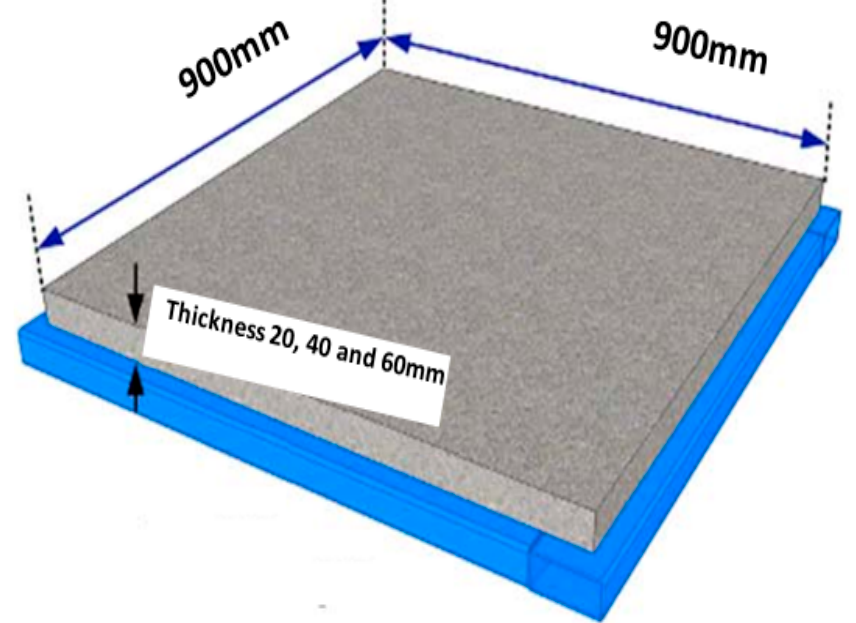
Figure 2. Details of SIFCON slab specimens.